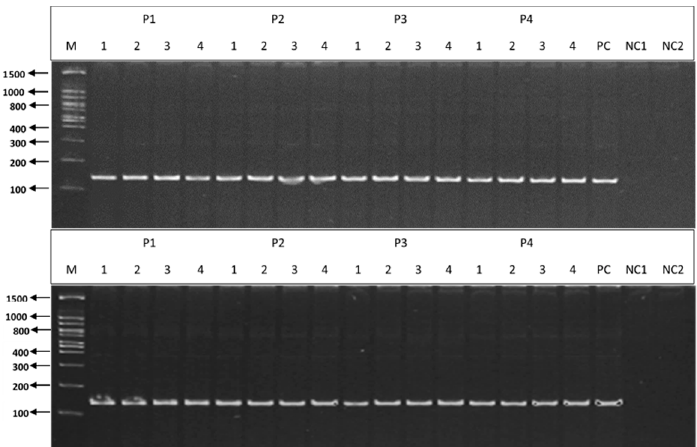
Figure 3. Detection of P. belbahrii in various organs of systemically infected basil plants that were inoculated at the 4-leaf stage. P1–P4: plant number. M—molecular markers (100–1500 bp). Lanes 1, 2, 3 and 4: PCR amplification products obtained from the apex, stem, petiole and hypocotyl, respectively. PC-positive control, amplification product (134bp) obtained from sporangia of P. belbahrii. NC1-negative control, amplification product obtained from leaves of control healthy basil plants. NC2-negative control-water.